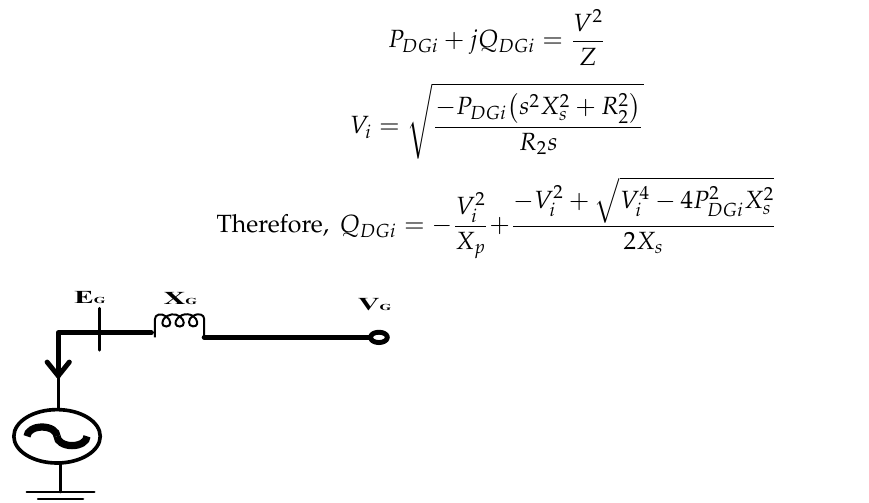
Figure 3. Equivalent circuit of synchronous generator.